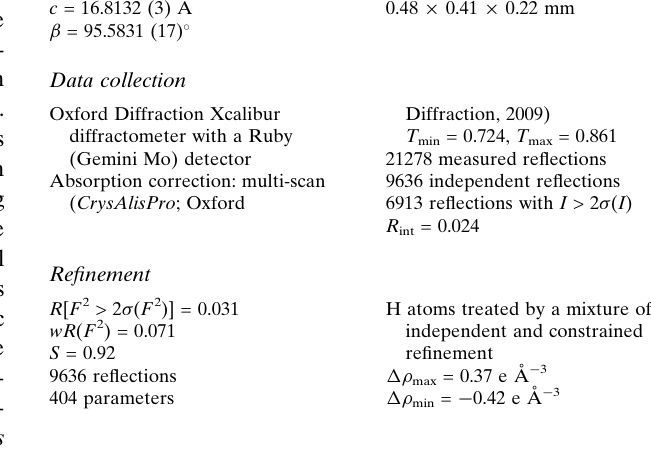
Data collection Oxford Diffraction Xcalibur diffractometer with a Ruby (Gemini Mo) detector Absorption correction: multi-scan ( CrysAlisPro ; Oxford